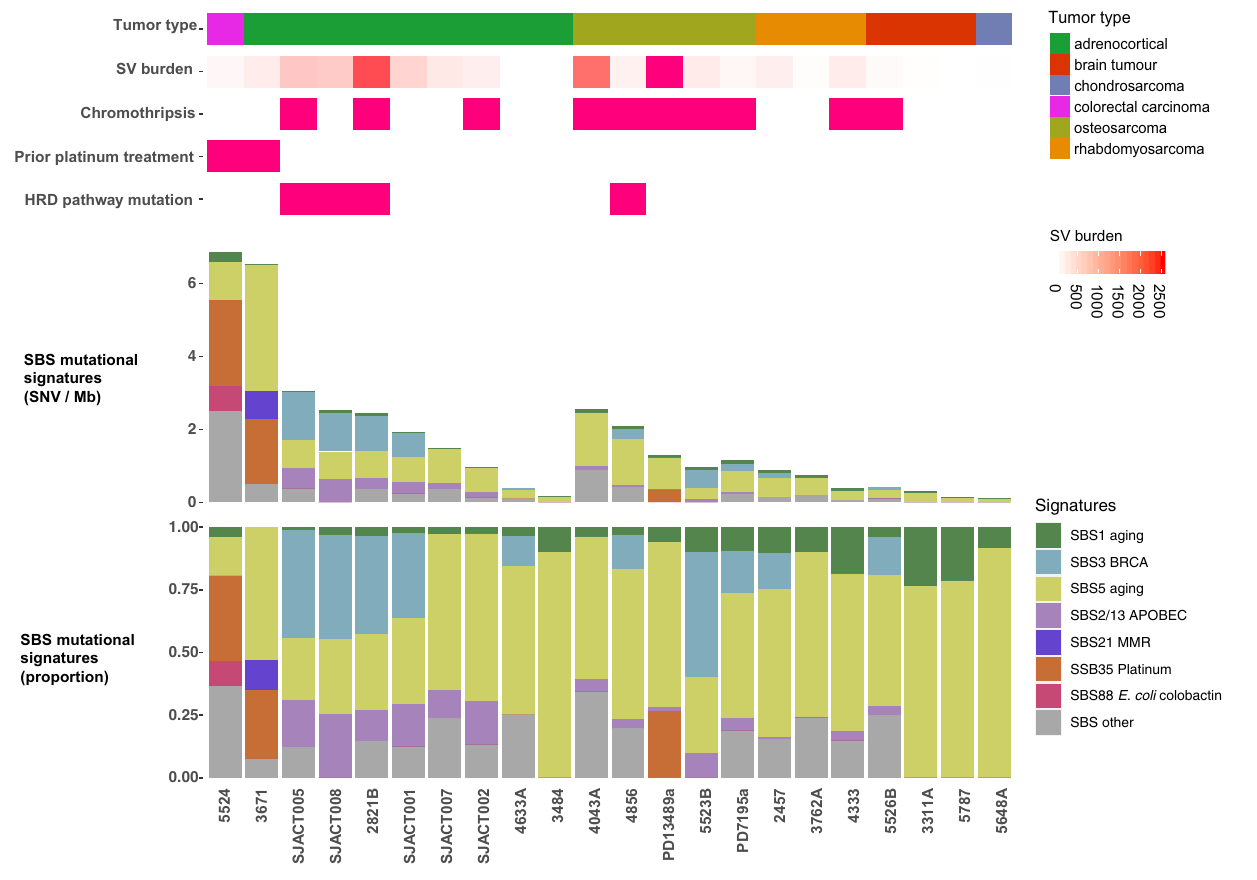
Fig.2|Themutationalsignaturesof TP53 -germlinemutantchildhoodtumors. Top: Clinical and genomic features of the tumors (number of structural variants (SVs), presence of chromothripsis, prior platinum treatment, HRD pathway mutation). Bottom: SBS mutational signatures corresponding to COSMIC